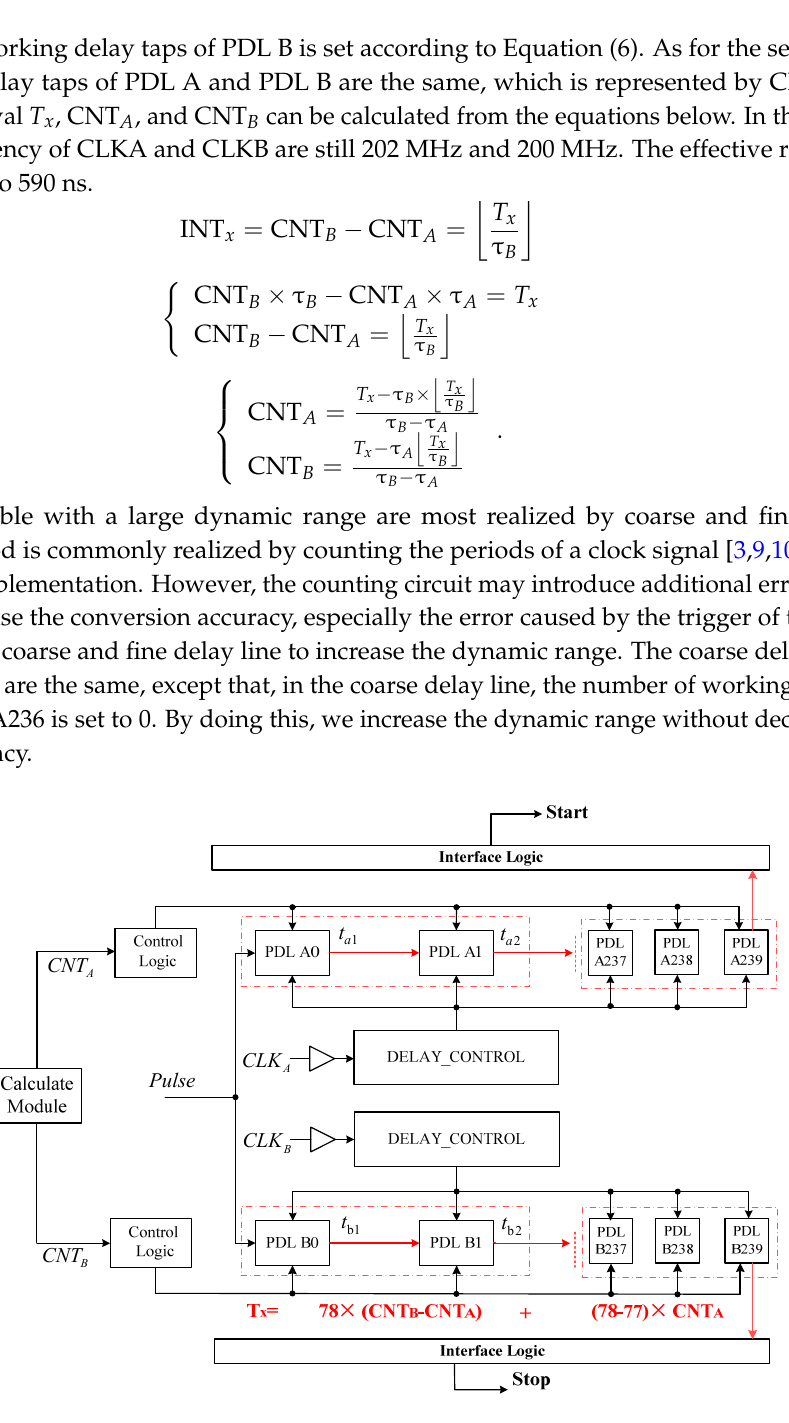
Figure 5. Modified block diagram of the proposed DTC.